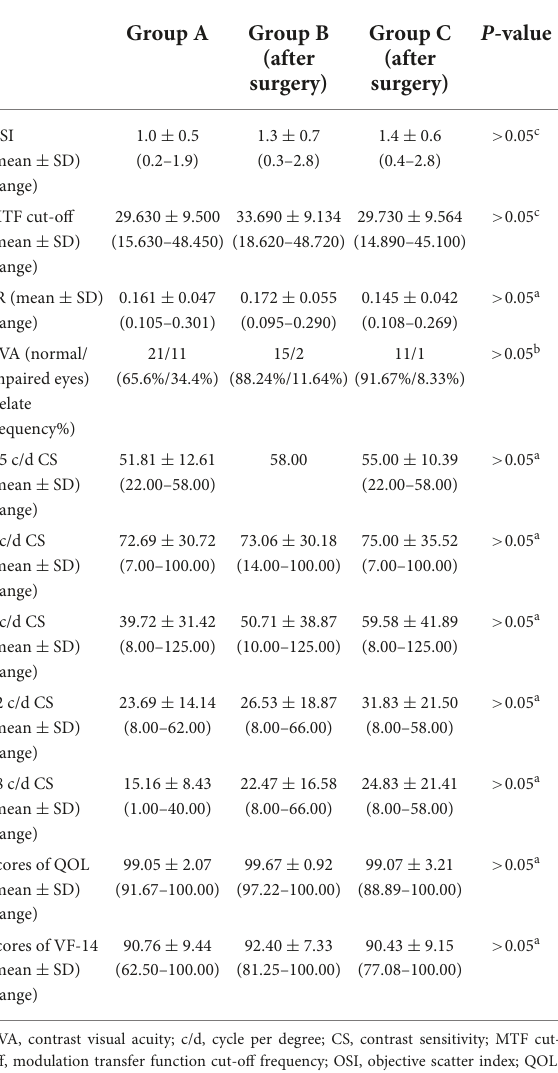
TABLE 3 Postoperative objective and subjective visual function indexes of the two groups with early cataracts and these parameters in control